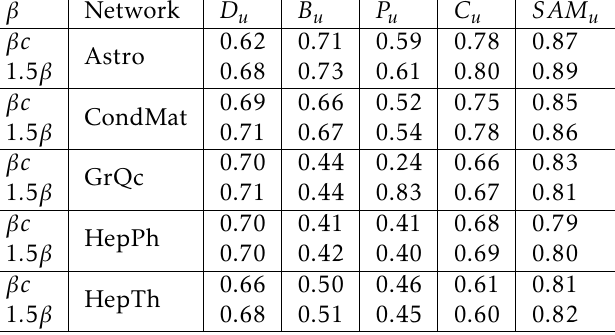
Table 7. KENDALL‘S Correlation with Probability β β